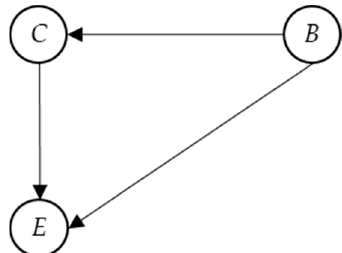
Figure 2. A causal graph example on the variable set V = { C , E , B } . Variable C and E are assumed to be the cause-and-effect variables, respectively. While B represents a set of confounder variables that need to be held fixed to analyse the causal relation between C and E